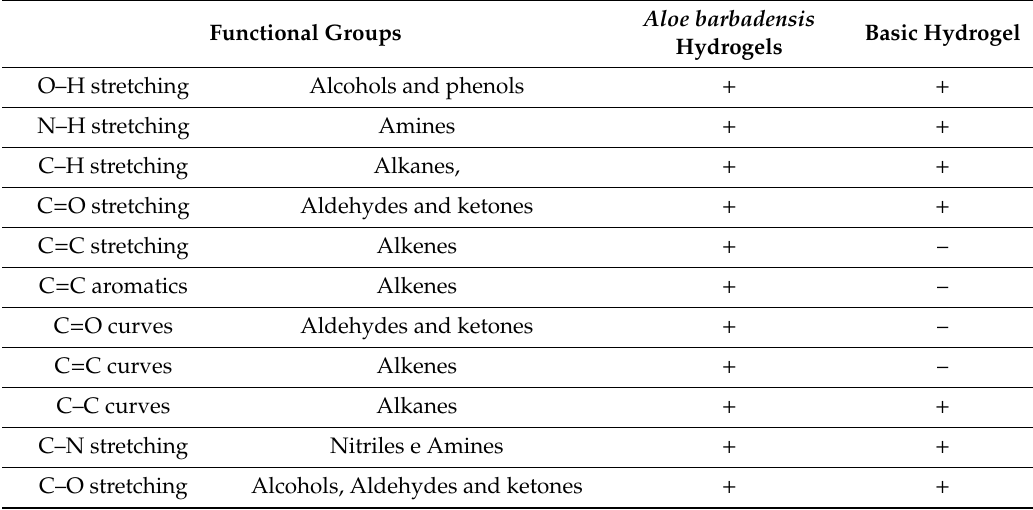
Table 2. Spectroscopic profile by Fourier Transform Infrared Spectroscopy (FTIR) of